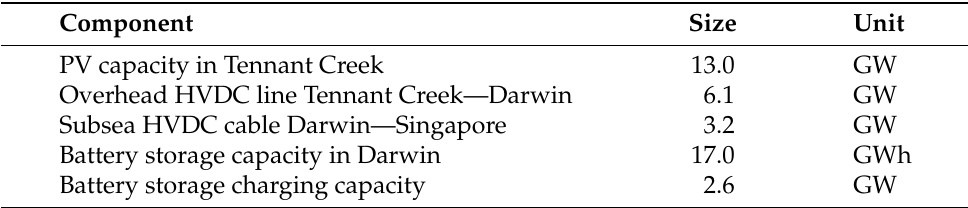
Table 3. Size of system components according to urbs for the reference